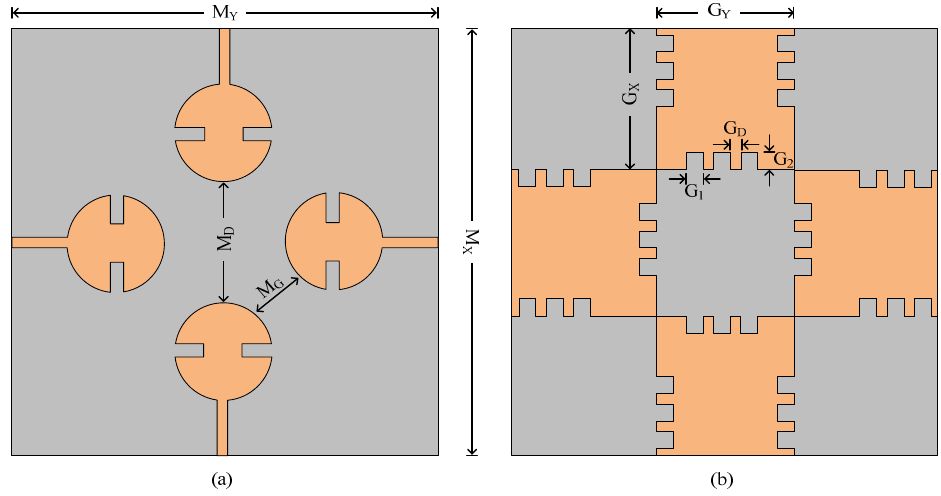
Figure 6. Geometrical configuration of proposed four-port MIMO antenna ( a ) top-view ( b ) back-view.